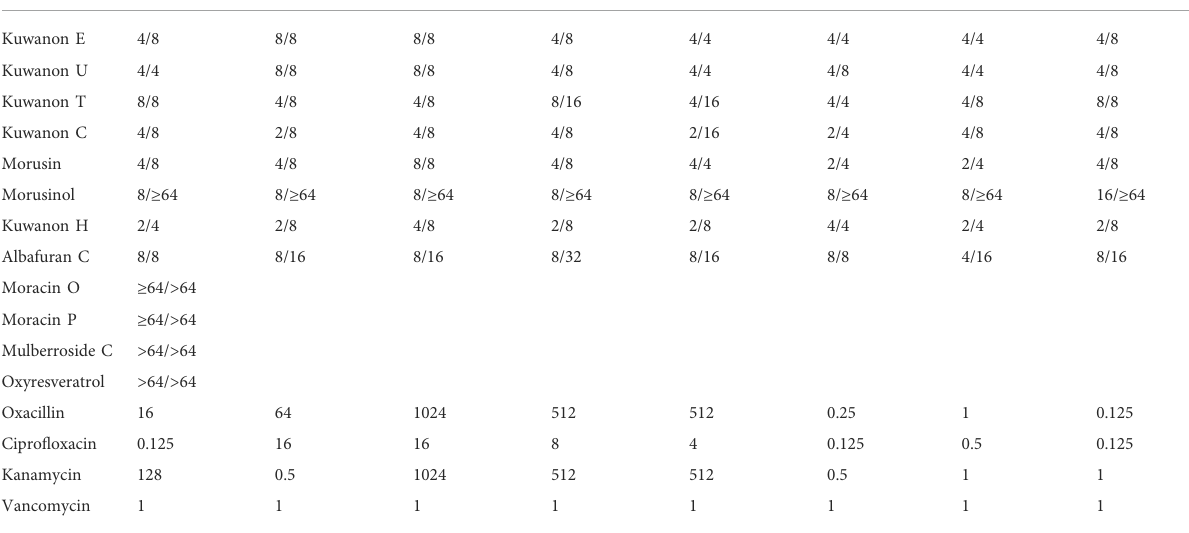
TABLE 2 MIC/MBC of natural compounds and MIC of antibiotics against MRSA and MSSA strains de fi ned in μ g/ml.